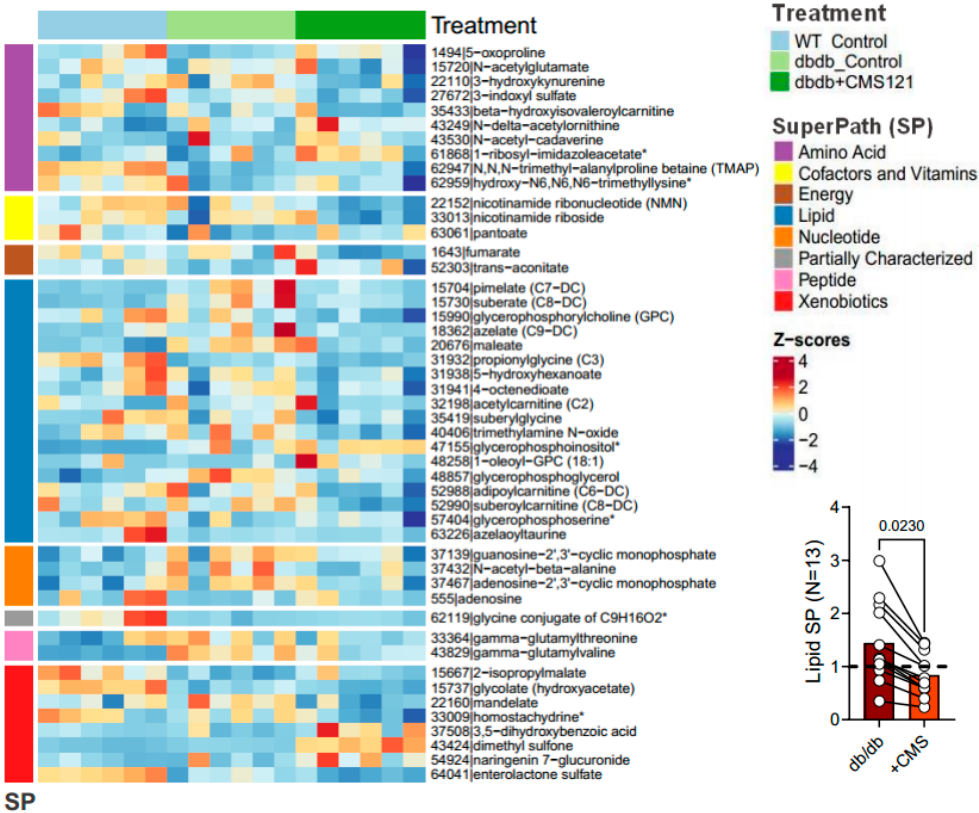
Figure 6. Heatmap of the Z-scores of CMS121-induced changes in control and CMS-treated db/db mouse urine metabolites. Graph insert depicts the metabolites related to fatty acid metabolism that were altered by the diet. The glycine conjugate (C 9 H 16 O 2 ) is a partially characterized molecule and was not considered in the analysis. * Indicates compounds that have not been confirmed based on a standard, but mass spectra data was appropriate to reveal its identity.